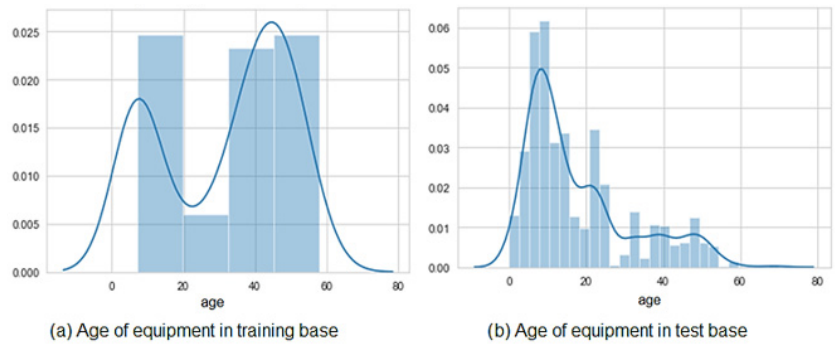
Figure 14. Age of equipment in the ( a ) training and ( b ) test bases [authors].